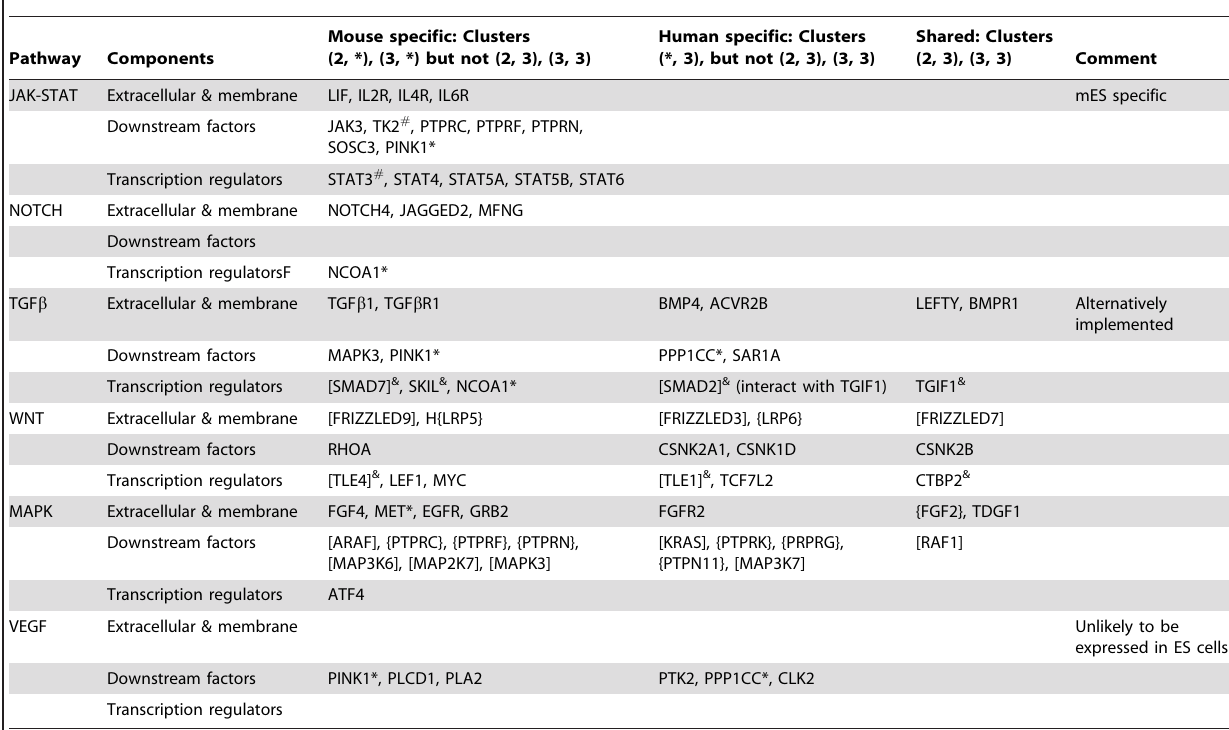
Table 1. Distribution of genes participating in six signaling pathways in the ES clusters.